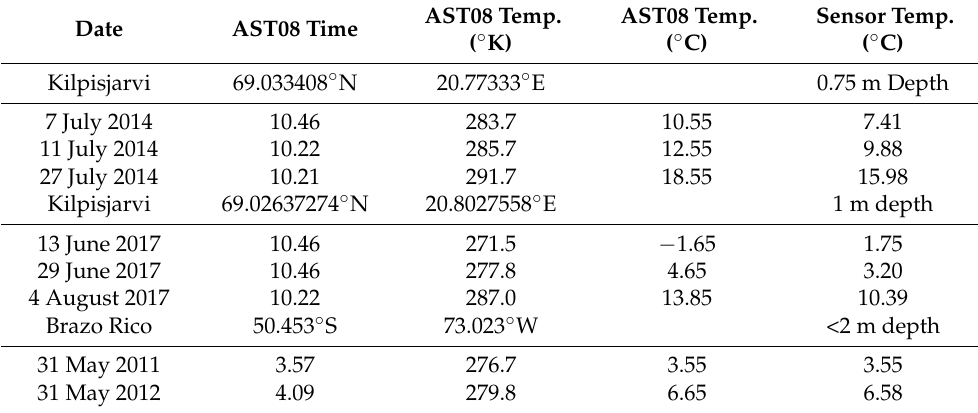
Table A1. Data points compiled for this survey for validation of the AST08 temperature product. Data measured in Kilpisjarvi (Sweden) from G. Kirrilin with an RBR Duo thermistor (accuracy ± 0.002 ◦ C) for temperatures (every minute) less than 1 m deep with an in situ buoy mooring. Data Brazo Rico arm of Lago Argentino, Argentina are from Onset HOBO U20 sensor (accuracy ± 0.5 ◦ C) mounted on a metal pole at <2 m depth and were kindly provided by M. Minowa and P. Skvarca. AST08